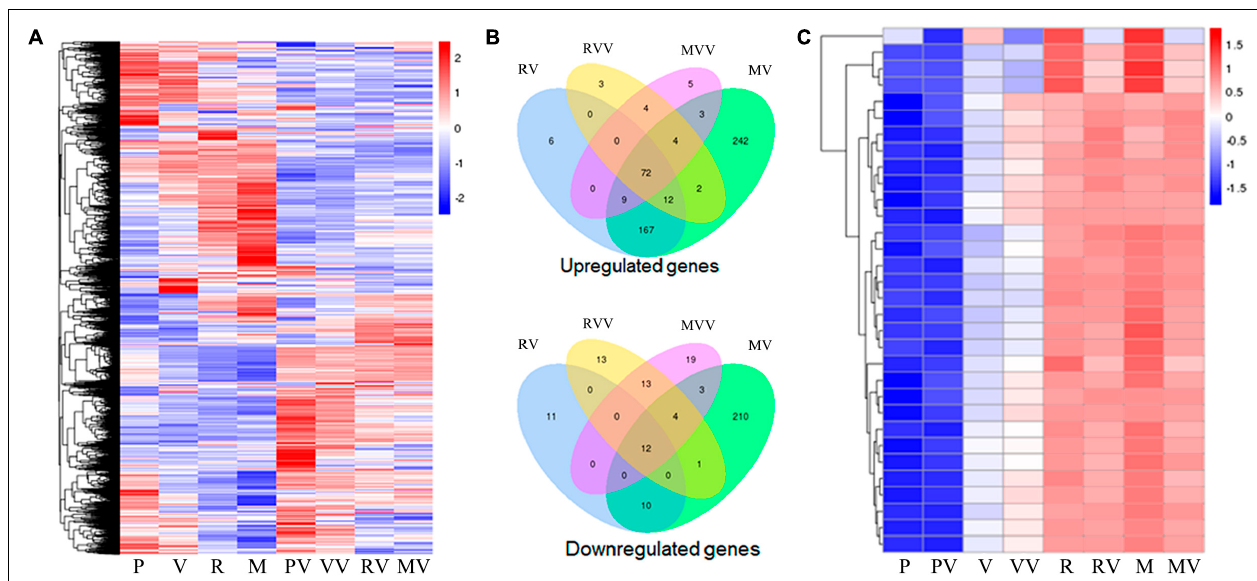
FIGURE 7 | The transcriptome analysis of CARDs transfected PAMs with or without H9N2 infection. (A) The heat map of clustered differentially expressed genes (DEGs) in porcine RIG-I and MDA5 transfected PAMs with or without H9N2 infection (0.01 MOI for 12 h). P, PAM mock control; V, pcDNA vector transfection control; R, porcine RIG-I CARDs; M, porcine MDA5 CARDs. The last V denotes H9N2 infection. (B) The Venn’s diagrams of several groups of DEGs. RV, RIG-I CARDs vs. pcDNA control; MV, MDA5 CARDs vs. pcDNA control; RVV, RIG-I-CARDs vs. vector control with H9N2 infection; MVV, MDA5-CARDs vs. vector control with